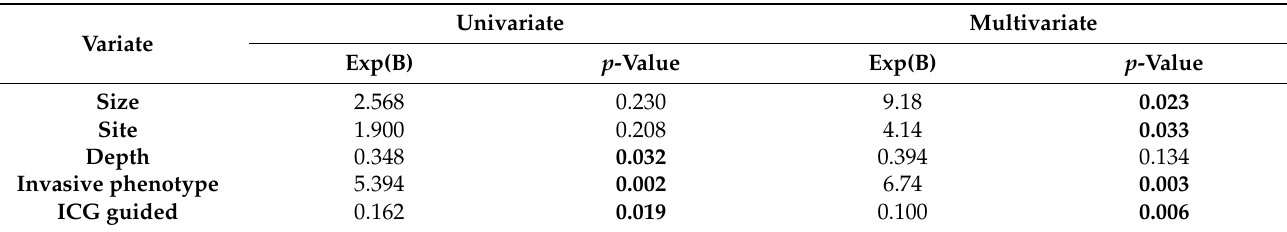
Table 4. Univariate and multivariate analysis of the relationship between risk factors and unexpected positive margin rates.